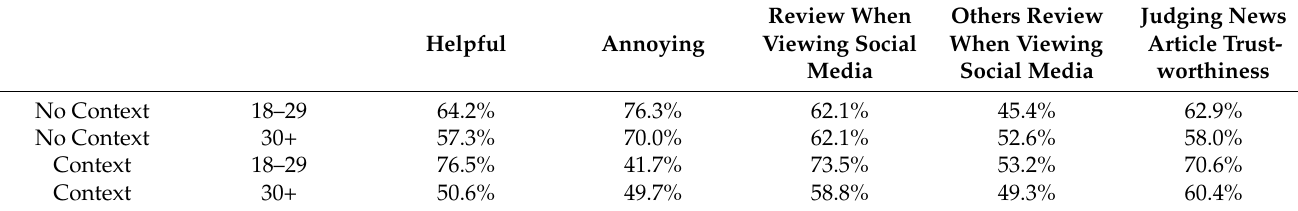
Table 23. Comparison of context versus no context by age